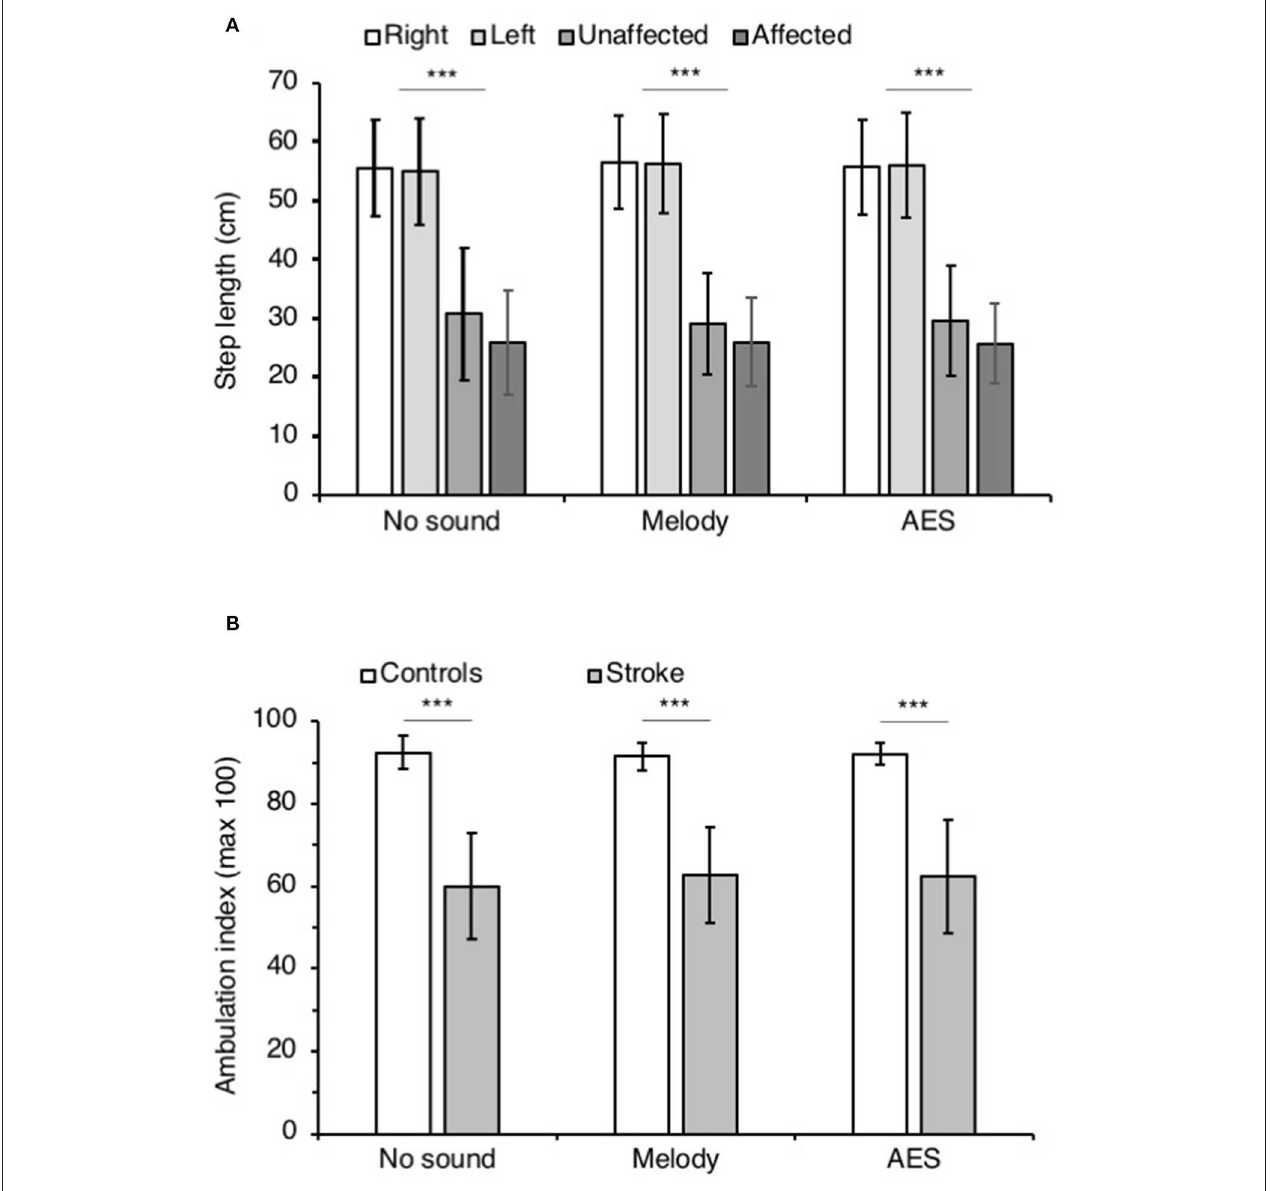
FIGURE 4 | Step parameters. (A) Mean step length (cm) in controls on the right (white columns) and the left side (light gray), and in patients with stroke on the affected (middle gray columns) and the unaffected side (dark gray columns). The vertical error bars indicate ± 1 × SD. (B) Mean ambulation index in controls (white columns) and in patients with stroke (gray columns). Vertical bars as in (A) . The step parameters were collected during walking without sound and when listening to melody or AES. *** p <